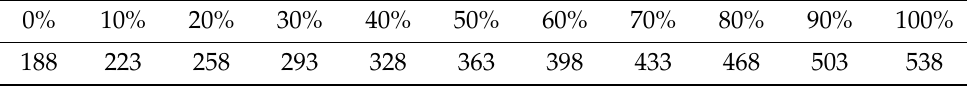
Table 2. Utilization wattage requirement ( watt ) [23].